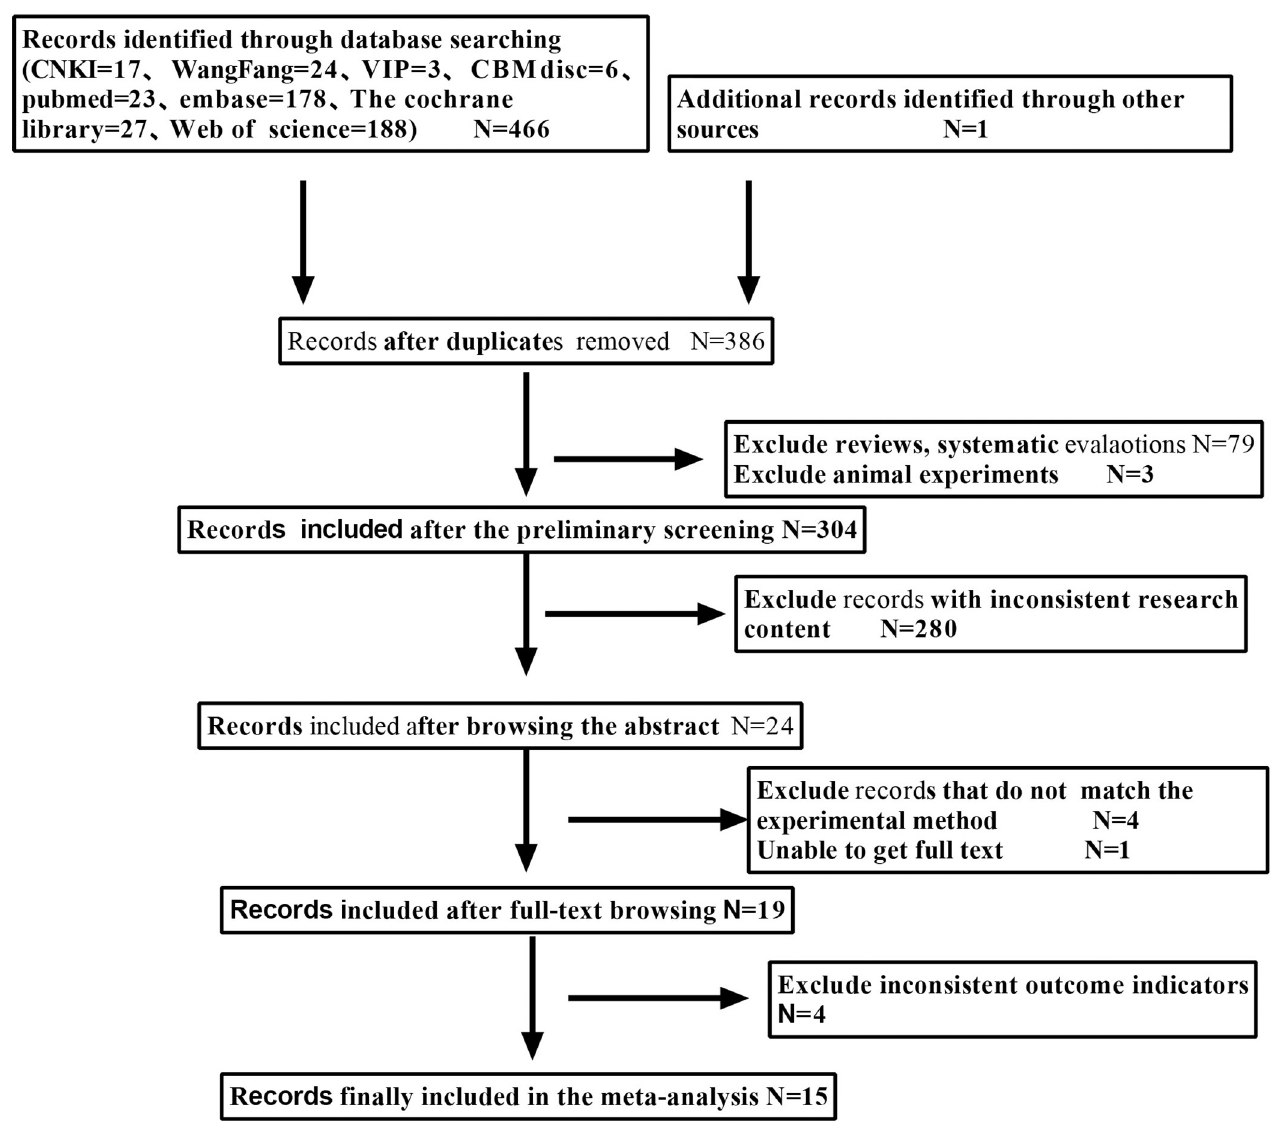
Fig 1. Document screening flow